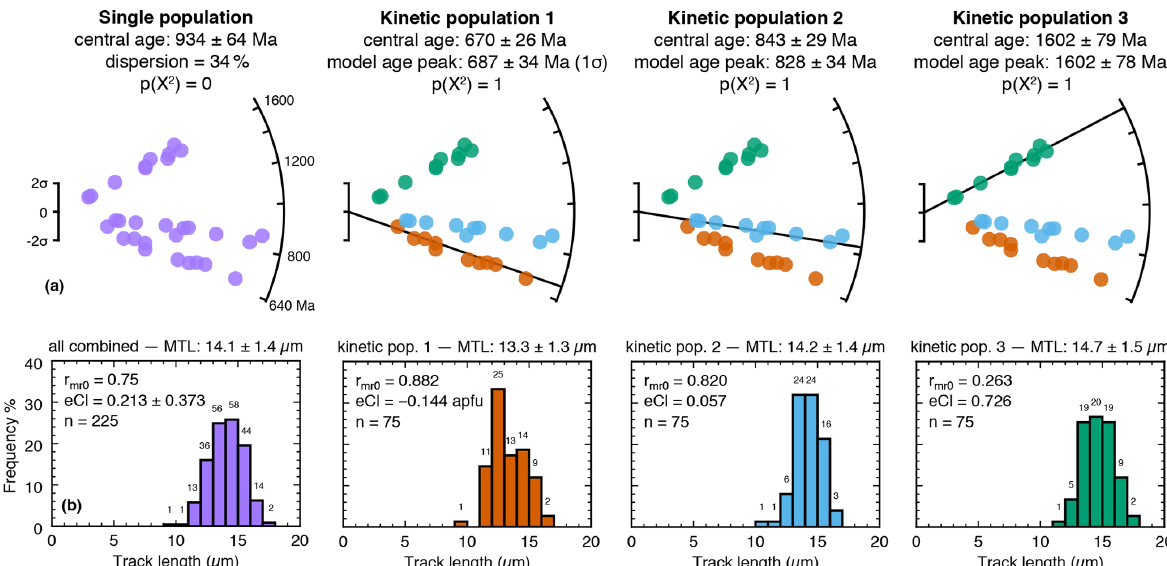
Figure 2. Predicted synthetic AFT data from the thermal history in Fig. 1. Multikinetic age populations were individually predicted using distinct r mr0 kinetics shown in (b) panels (discussed in the text). These data were then input in QTQt and inverted to recover the true thermal history in Fig. 1 (see Fig. 3). (a) Central age and 1 σ errors are indicated for each kinetic population. Throughout this paper, “central age” is used for historical reasons to refer to the approximate geometric mean of a population of single-grain AFT ages (Galbraith and Laslett, 1993). The first radial plot shows all 30 individual grains and demonstrates that when taken together, the combined sample fails the X 2 test ( p < 0.05) for homogeneity (i.e., that all grains belong to a single underlying age population). This suggests the presence of multiple age populations and is the scenario most researchers would start with before evaluating the sample for potential multikinetic behaviour. Mixture modelling was subsequently performed on the combined sample, and the model age peaks that were picked seamlessly align with the individual kinetic population central ages. Kinetic populations one, two, and three are displayed as arms on their respective radial plots, with individual AFT ages closer to the origin being less precise. This aligns with how model populations would be selected and compared with the elemental chemistry for individual age grains during multikinetic interpretation for natural samples (see Schneider and Issler, 2019; McDannell et al., 2019b). (b) The predicted track length distributions for the combined and individual kinetic populations derived from the thermal history in Fig. 1 using the specified kinetic parameter value. Numbers on the histogram are the number of tracks in each 1µm bin. Abbreviations: eCl – effective Cl; MTL – mean track